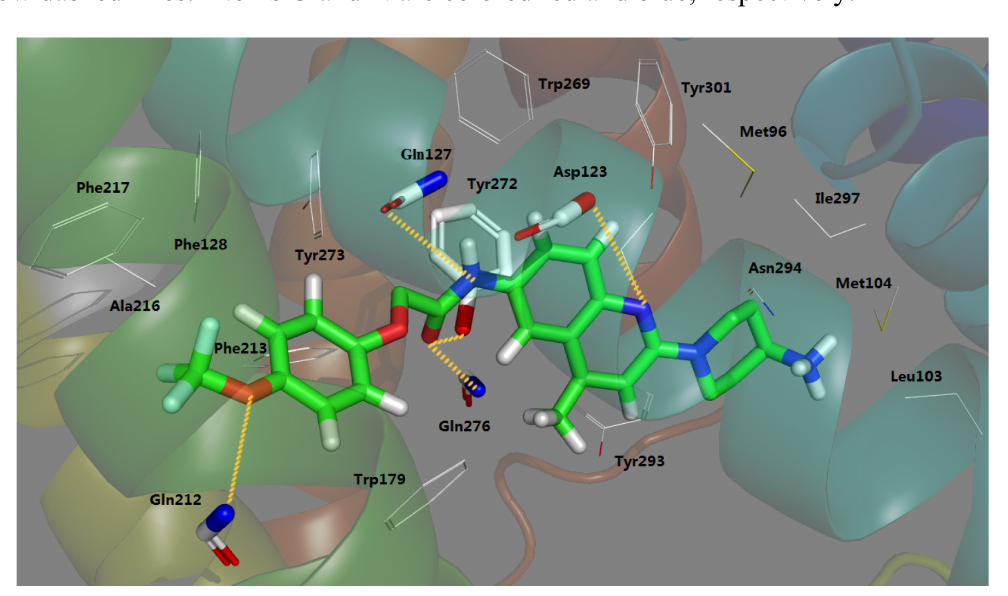
Figure 7. Plot of the in-water MD-simulated structures of the binding site. Compound 169 and interaction groups of the crucial amino acids are represented in sticks and highlighted with green and white carbons, respectively. Hydrogen bonds and salt bridges are shown as yellow dashed lines. Atoms O and N are colored red and blue, respectively.